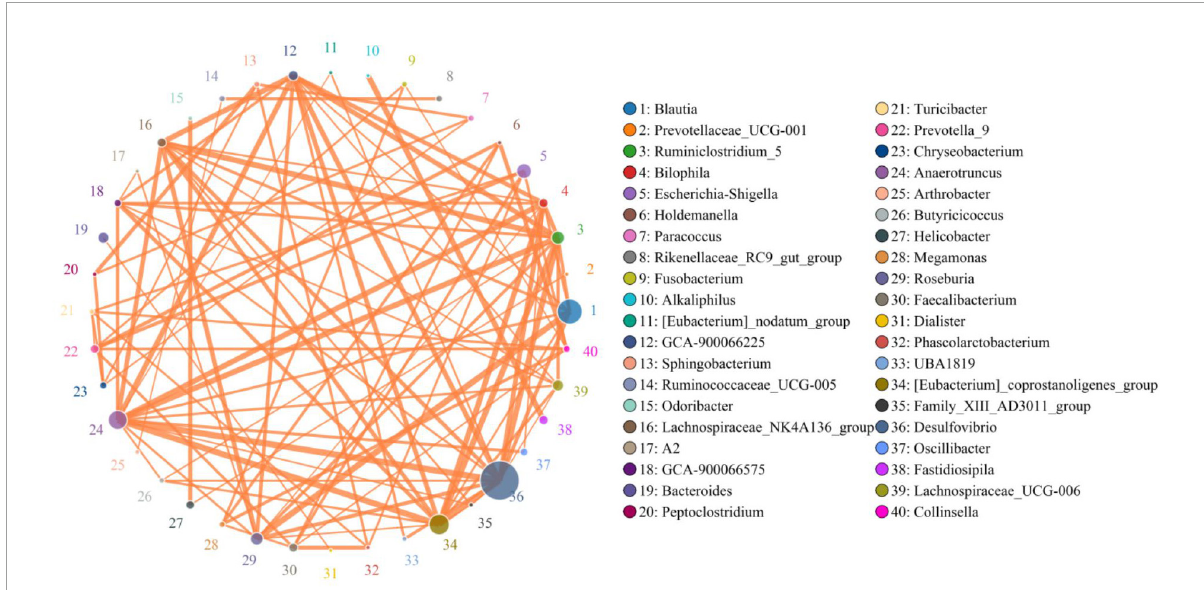
FIGURE4 The correlations between different bacteria was assessed by network diagram. The orange lines indicate positive correlation.